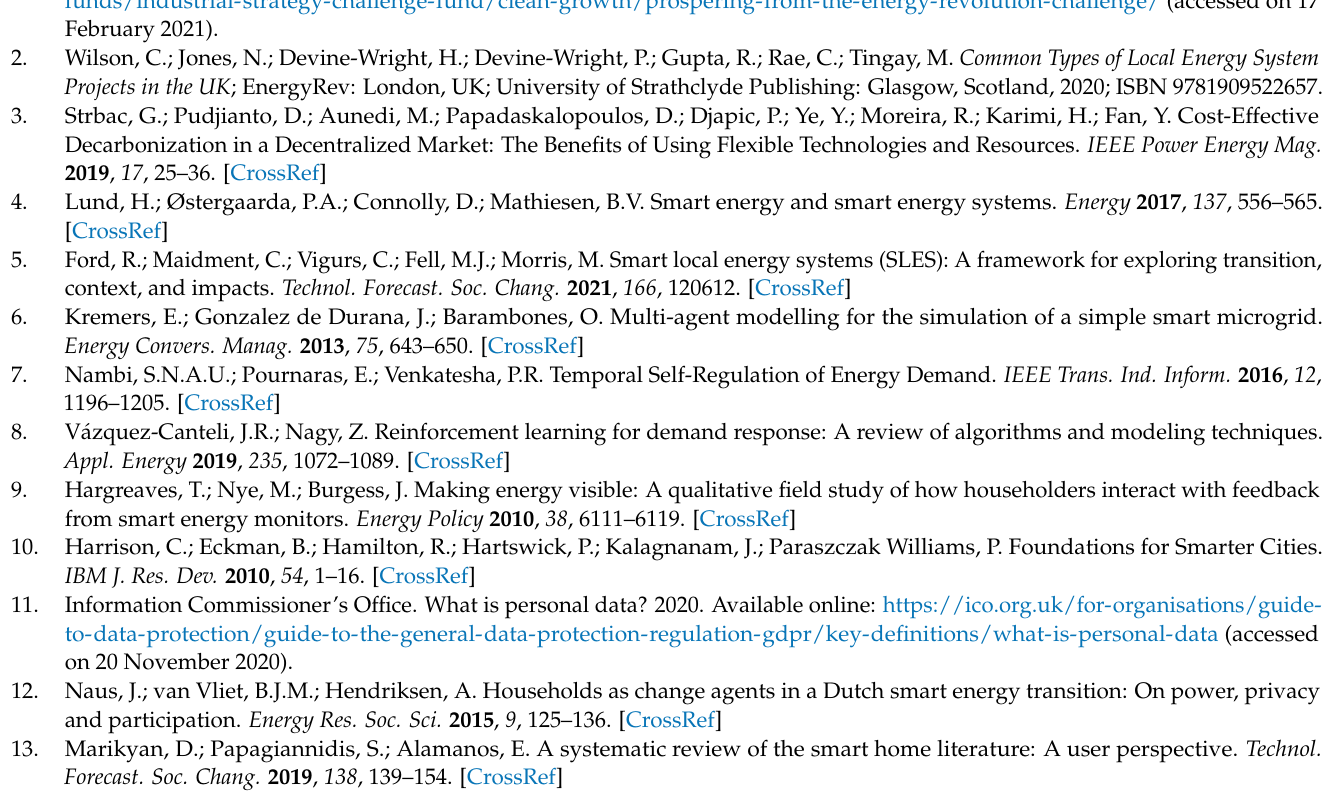
bibliographic databases. Table S3. Hypothesised contexts, mechanisms, and outcomes for guiding principle 1. Table S4. Hypothesised contexts, mechanisms and outcomes for guiding principle 2. Table S5. Hypothesised contexts, mechanisms and outcomes for guiding principle 3. Table S6. Hypothesised contexts, mechanisms, and outcomes for guiding principle 4. Table S7. Hypothesised contexts, mechanisms, and outcomes for guiding principle 5. Table S8. Hypothesised contexts, mechanisms, and outcomes for guiding principle 6. Table S9. Hypothesised contexts, mechanisms, and outcomes for guiding principle 7. Table S10 Hypothesised contexts, mechanisms, and outcomes for guiding principle 8. Table S11. Data sharing technologies and systems in each domain. Table S12. Study characteristics and quality appraisal for included primary